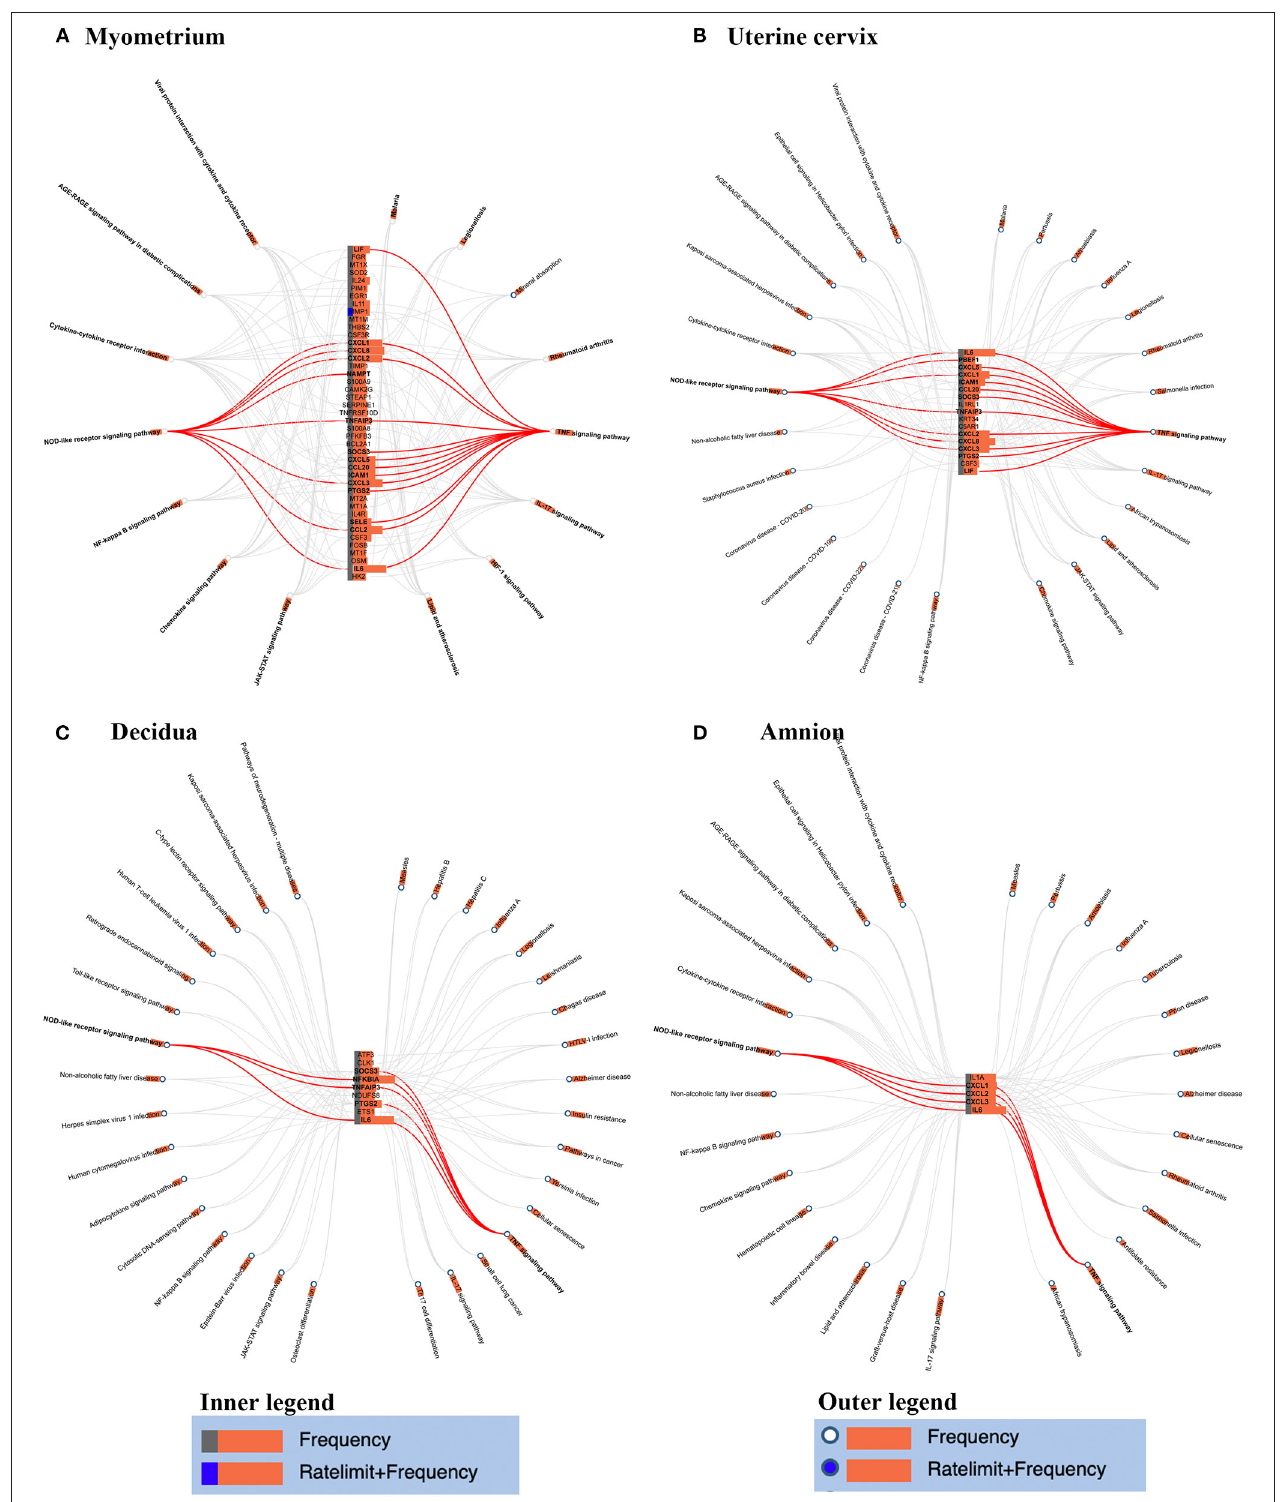
FIGURE 3 | Genes-pathways network in myometrium (A) , uterine cervix (B) , decidua (C) , and amnion (D) . Genes involved in the two pathways (i.e., TNF signaling pathway and NOD-like receptor signaling pathway) which enriched in the four tissues were highlighted by red line.